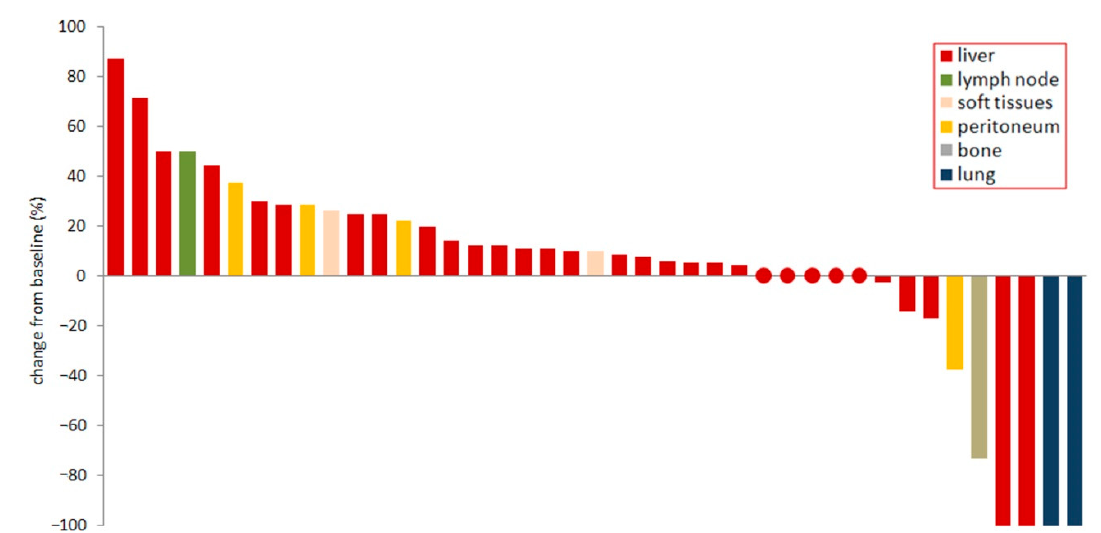
Figure 2. Best percentage change in single lesions. Best percentage change from baseline depicted for every single lesion analyzed. Circles indicate liver lesions with null change.